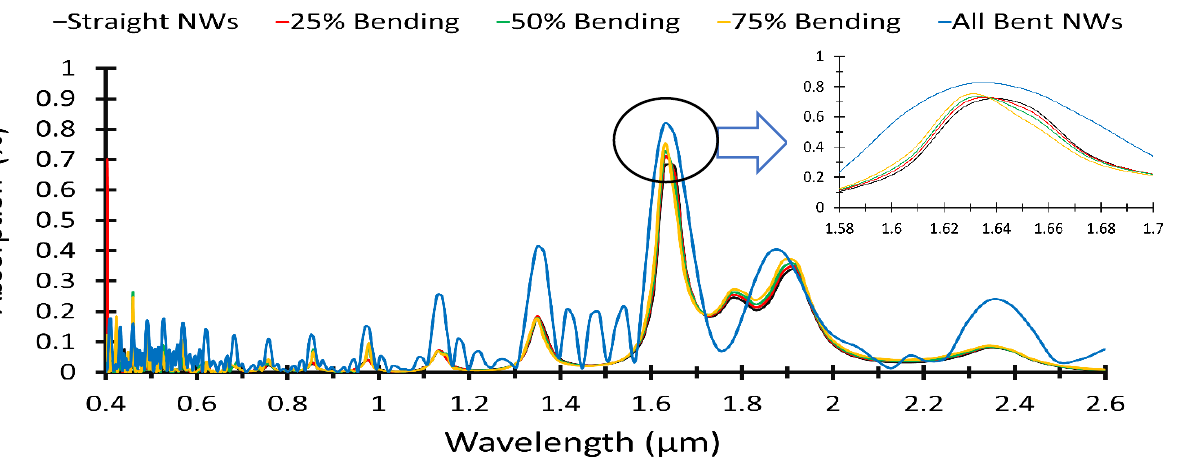
Figure 8. Light absorption for different concentration of bent NWs ranging from 0% (no bending) to 100% (NWs in the given simulation cell are all bent).